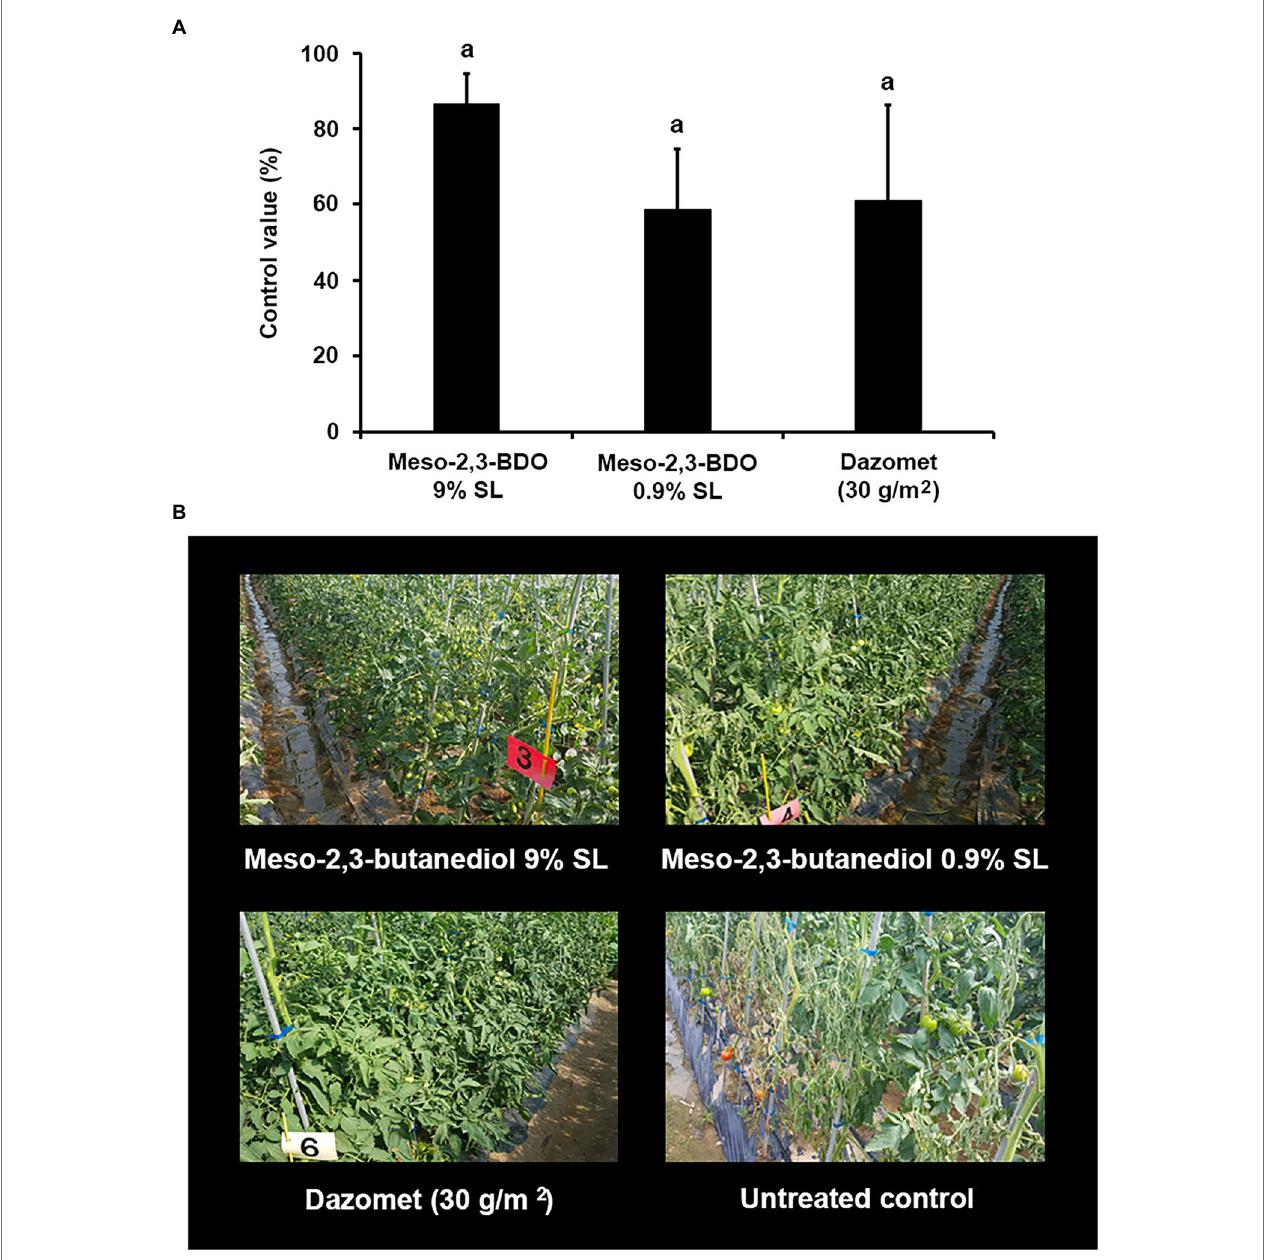
FIGURE 5 | Disease control efficacy of meso-2,3-BDO on tomato bacterial wilt caused by R. solanacearum under the field conditions. 2,3-BDO treatment was applied by preparing meso-2,3-BDO in 9% soluble concentrate (SL) and 0.9% SL. After transplantation, the tomatoes were irrigated four times at 7-day intervals at 200 ml of the 1,000-fold diluent of meso-2,3-BDO 9% SL or meso-2,3-BDO 0.9% SL per plant by soil drench. As a positive control, plants were treated with Dazomet at 300 kg per 1 ha. (A) Control value was investigated 40 days after pathogen inoculation. The data show the means ± SD ( n = 4). Lower-case letters indicate statistically significant differences as compared to untreated control plants ( p < 0.05) according to Tukey’s HSD test. Error bars indicate the SDs. (B) Representative photographs of tomato plants after naturally occurring tomato bacterial